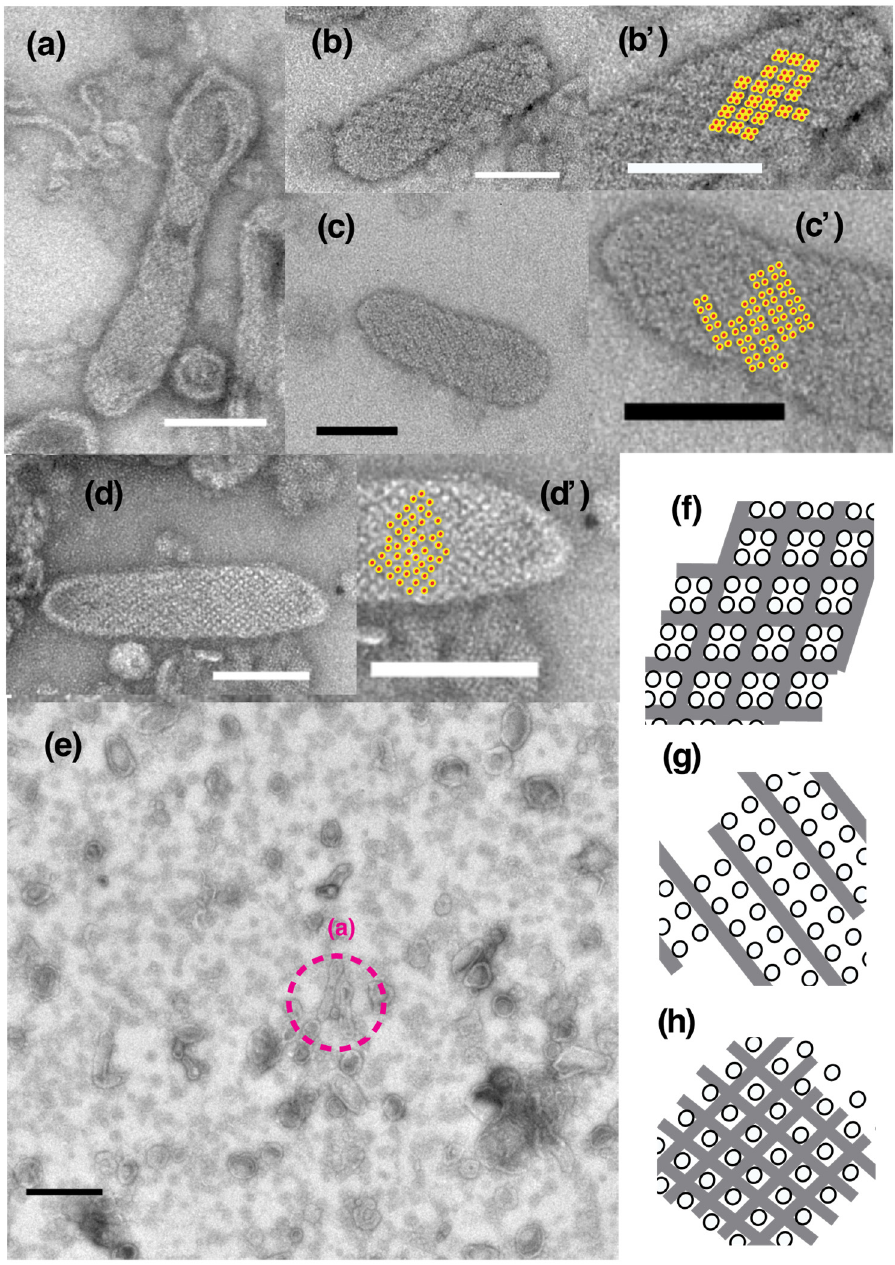
Figure 3. Typical images of tightly elongated SR vesicles, predominantly displaying one of the three different crystalline arrays: tetragonal, “two-rail” and monomer arrays of 40 Å particles. ( a , b , b’ ) Vesicles with the tetragonal array. ( b’ ) Higher magnification image of the vesicle in ( b ). The four particles within the tetragons observed in ( b ) are marked with the dotted circles in ( b’ ) (see text for details). A darker trench was observed between the tetragonal units. ( c ) Vesicles with the “two-rail” array. ( c’ ) Higher magnification image of the vesicle in ( c ). Each “two-rail” array was separated by a darker trench. ( d ) Vesicles with a monomer array. ( d’ ) Higher magnification image of the vesicle in panel ( d ). Each monomer is surrounded by a darker trench. ( e ) An overview picture of the vesicle populations. The dotted-circle ( a ) shown in ( e ) indicates the vesicle with a tetragonal array shown in ( a ). ( f , g , h ) Illustrations of the tetragonal, two-rail and monomer arrays, respectively. The SR vesicle preparations were incubated at about 0.003 ( d ), 0.03 ( a , b , e ) and 0.11 ( c ) µM Ca 2+ in the absence of ATP for 1 min after the addition of DDW (see “Section 4. Materials and Methods”). Scale bars in ( a – d ): 100 nm. Scale bar in ( e ): 0.5 µm.